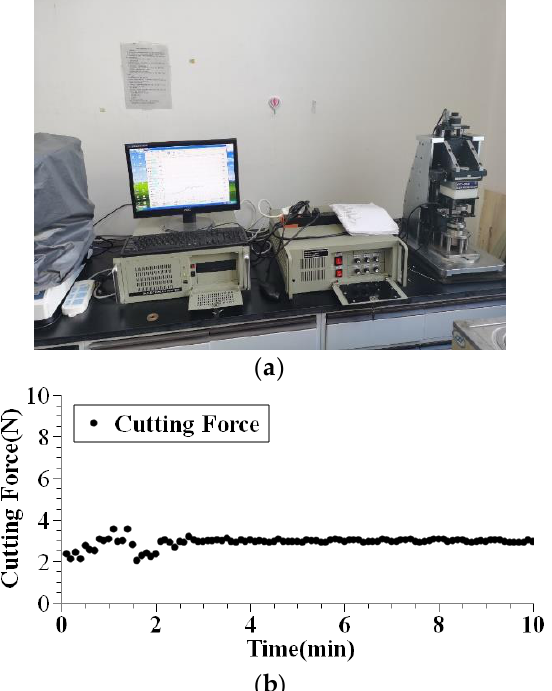
Figure 9. Experimental setup with ( a ) output of SFT-2M tribometer ( b ) cutting force measurement.